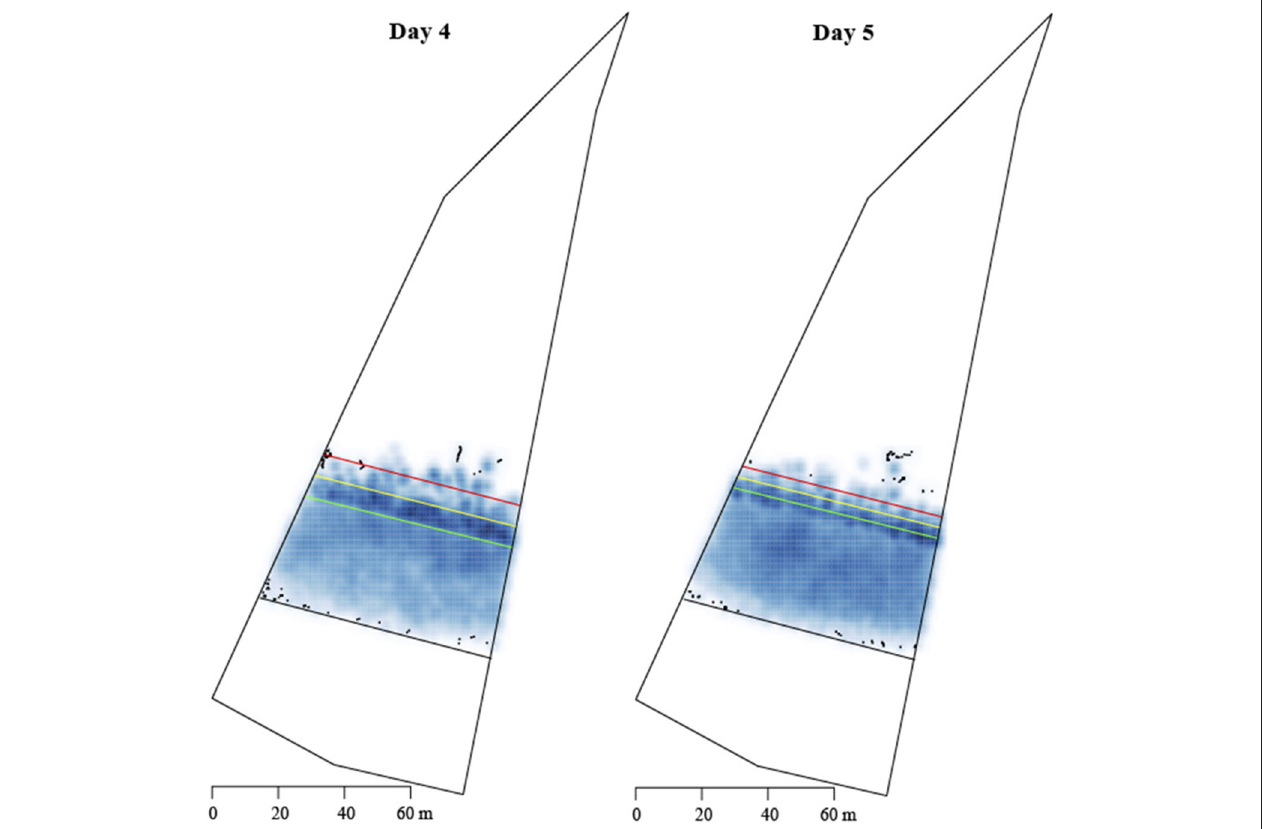
FIGURE 4 | Density maps of all cows within the allocation 4 on a grazing day (Day 4, left) and a hold-off day (Day 5, right). Scale 0–60m of the paddock. The clear dots represent an isolated point distant from any others and as such no smoothing has occurred. The zones are depicted with the colored lines. inclusion zone; buffer zone; exclusion zone; physical